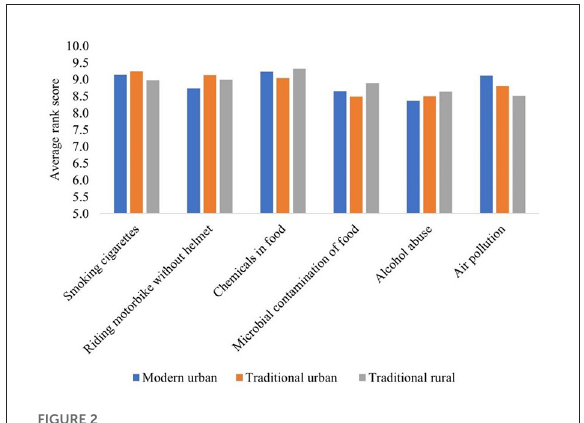
FIGURE2 Ranking of different risks to their health on a scale from 1 to 10 (10 being the most harmful to their health) by pork consumers at three retail types in Northern Vietnam in 2019 ( n =